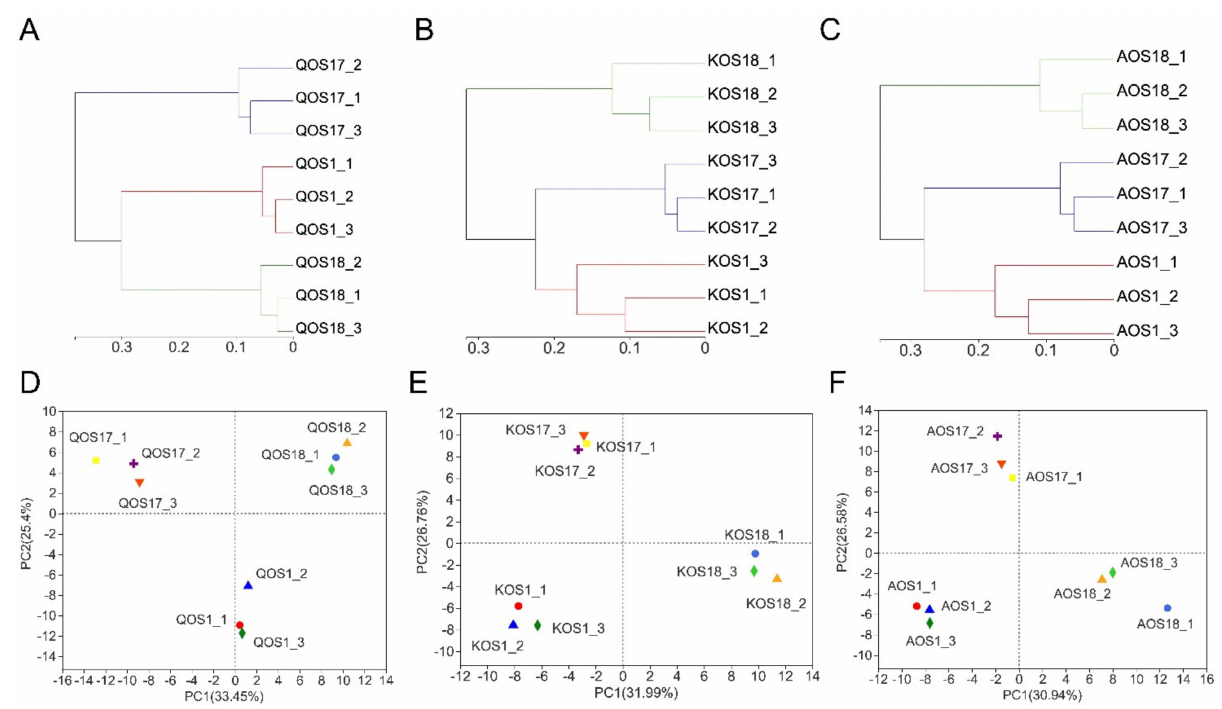
Figure 3. The β − diversity analysis of the gut microbiota. Clustering analysis of the gut microbiota ( A – C ). PCA score plot analysis of the gut microbiota ( D – F ). QOS1 denotes fermentation of QOS by gut microbiota F1. QOS17 denotes fermentation of QOS by gut microbiota F17. QOS18